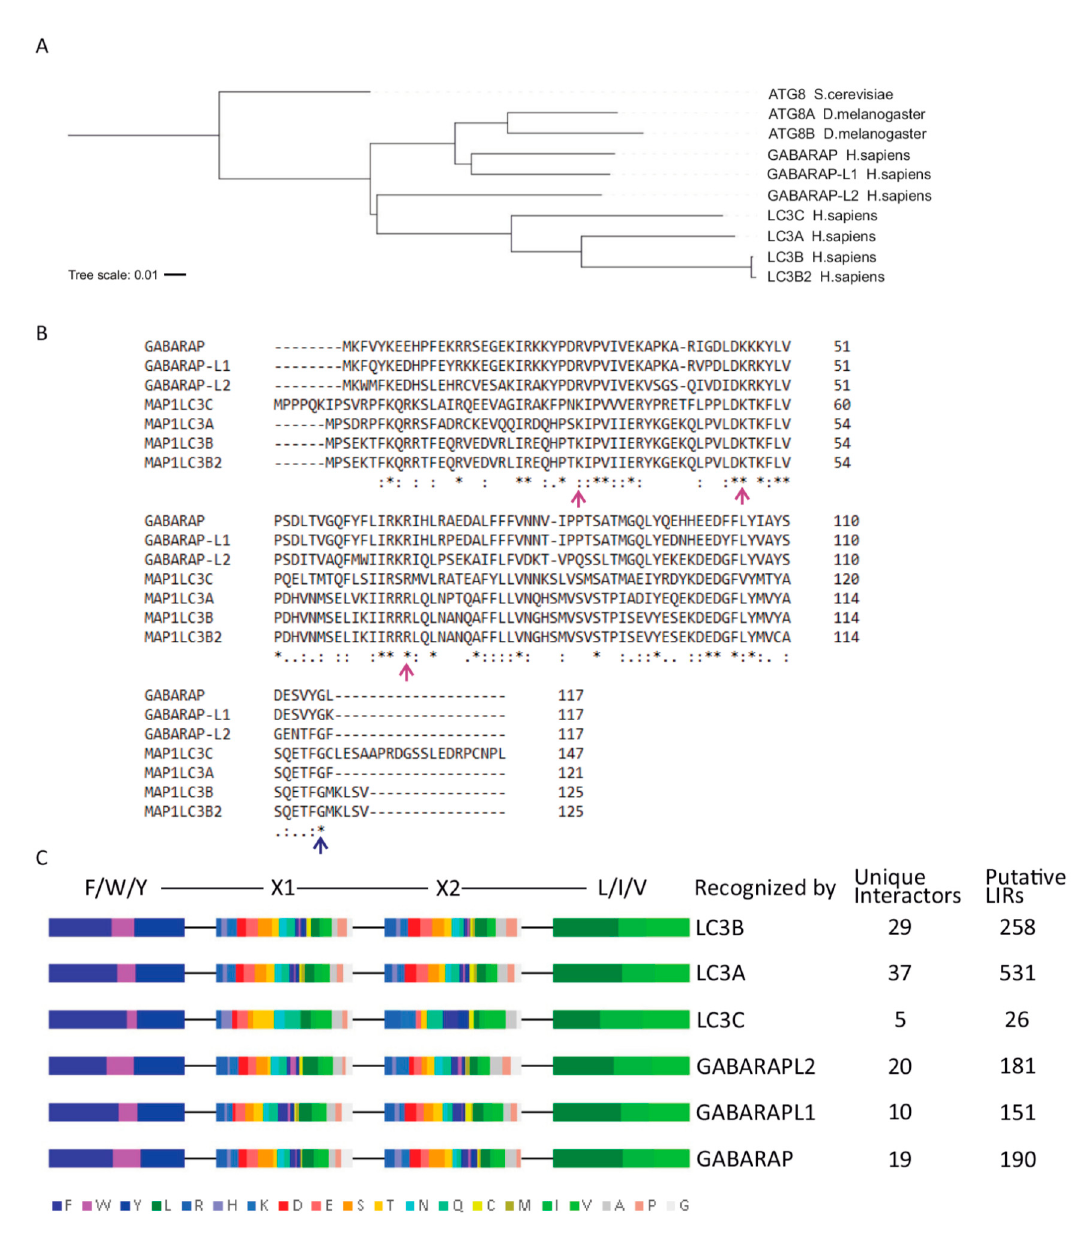
Figure 11. In silico sequence and binding partner analysis for the ATG8 protein family. ( A ) Phylogenetic tree of the ATG8 gene family featuring H. sapiens LC3A, LC3B, LC3B2, LC3C, GABARAP, GABARAP-L1, and GABARAP-L2, D. melanogaster ATG8A and ATG8B as well as S. cerevisiae ATG8. ( B ) Protein sequence alignment indicating identical (*), conserved (:) and semi-conserved (.) amino acids. Residues that have been found essential for ATG7 binding are indicated by a purple arrow, the conserved lipidation site glycine is marked with blue. ( C ) Meta-analysis of the amino acid composition of all putative (4-amino-acid) LIR motifs of the indicated number of recognized, exclusive ATG8 interactors as published [18]. The relative amino acid abundance for each position of a LIR motif was calculated and is shown by the indicated